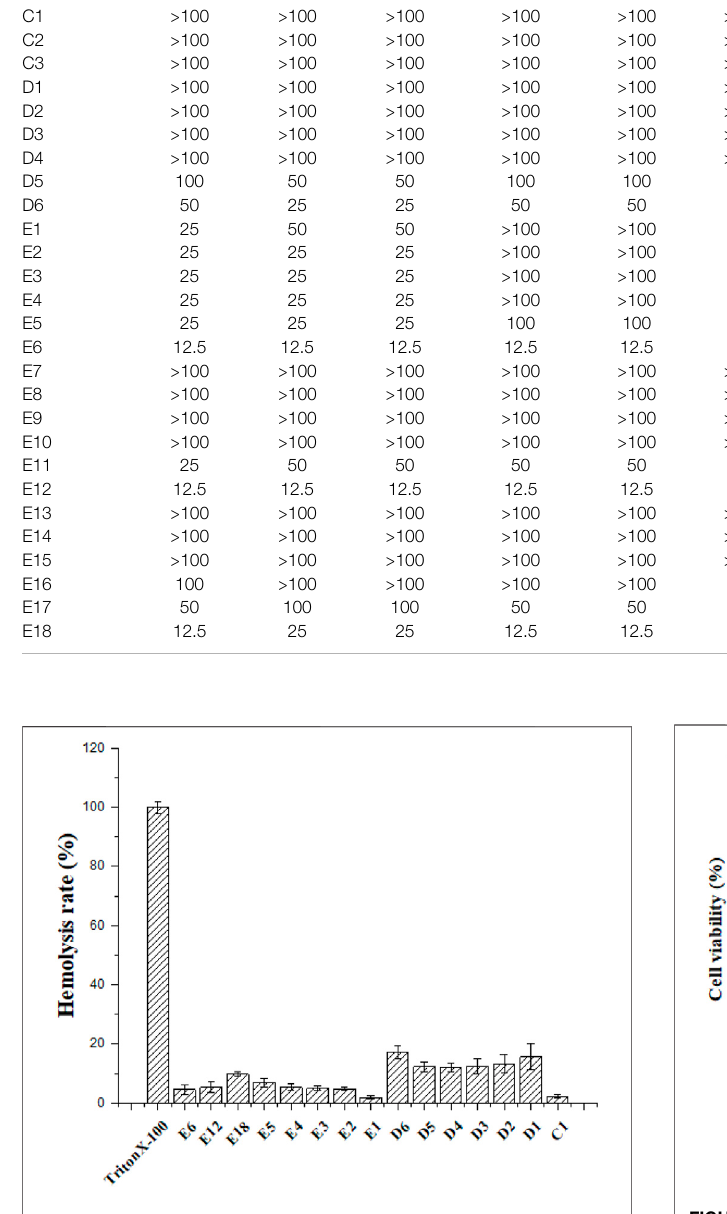
FIGURE 1 | Hemolytic activity of the partial compounds. FIGURE 2 | Cell viability of Caco-2 cells after treatment of different concentrations of E6, E12 and